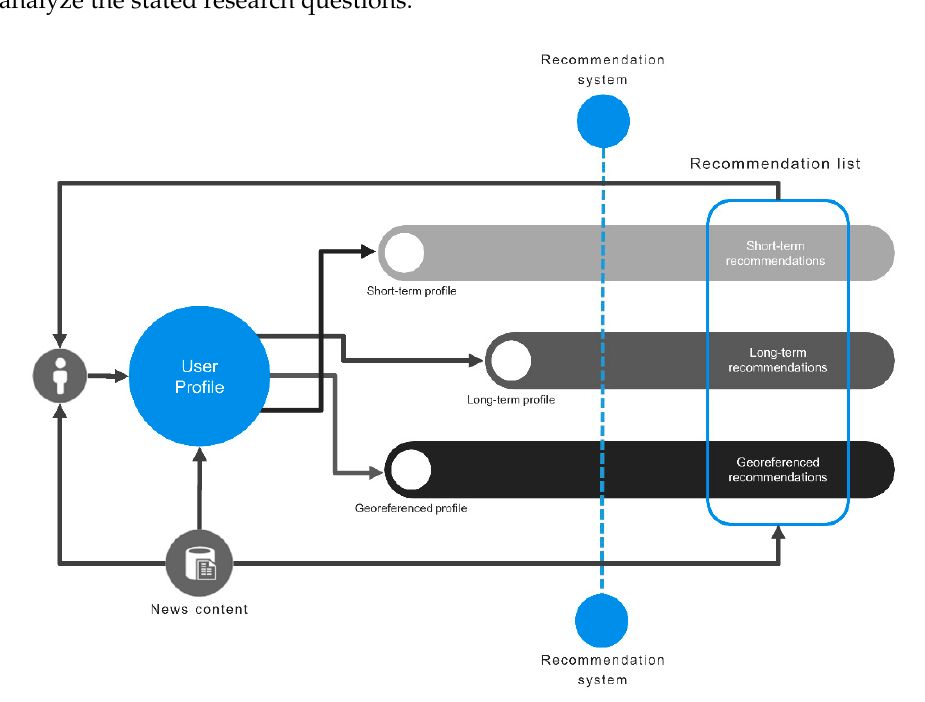
Figure 1. News recommendation system main elements.